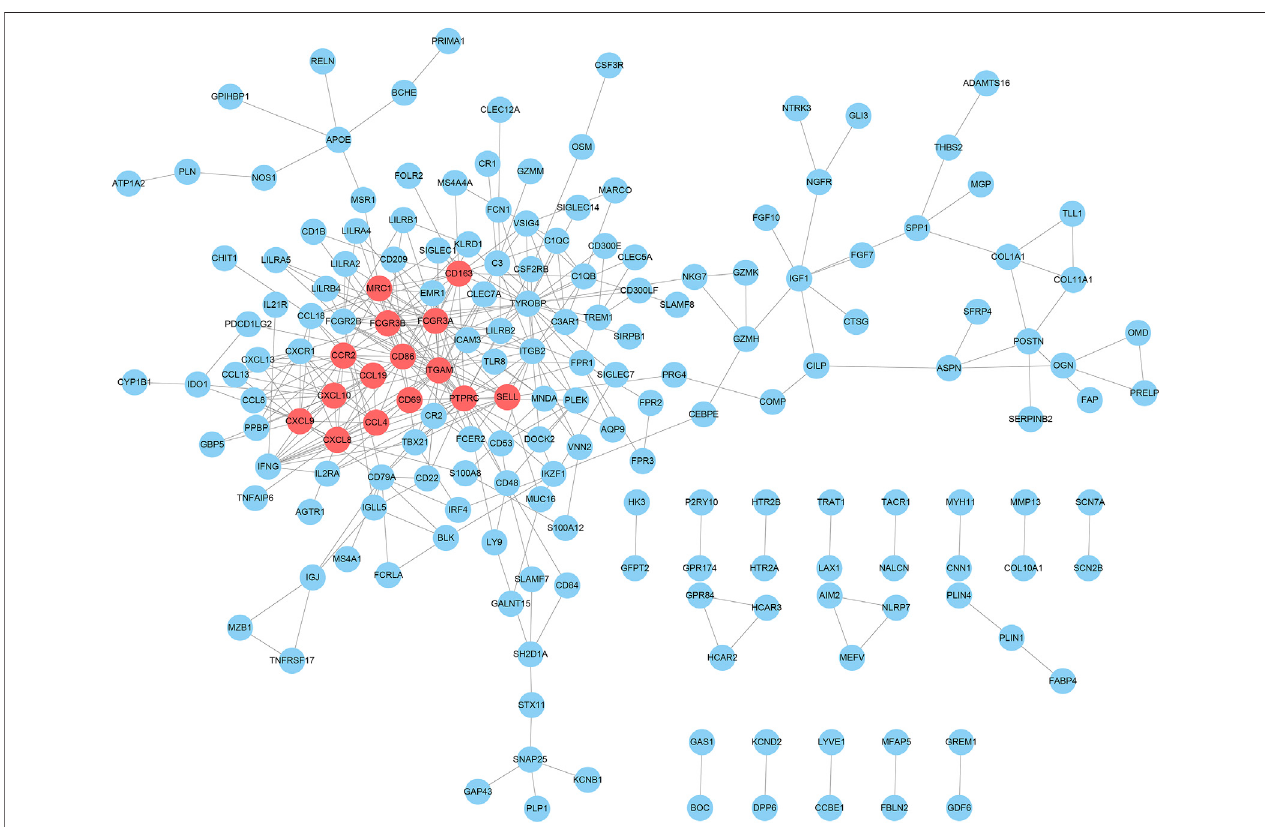
FIGURE 5 | PPI network analysis of DEGs and their hub genes screen. The hub gene nodes were highlighted in red.